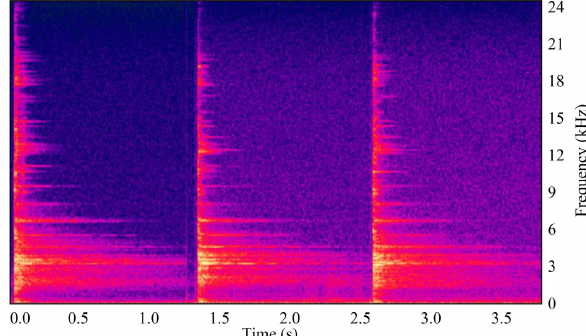
Fig. 5. Spectrograms of three responses captured at different loads, 0 %, 50 % and 95 %